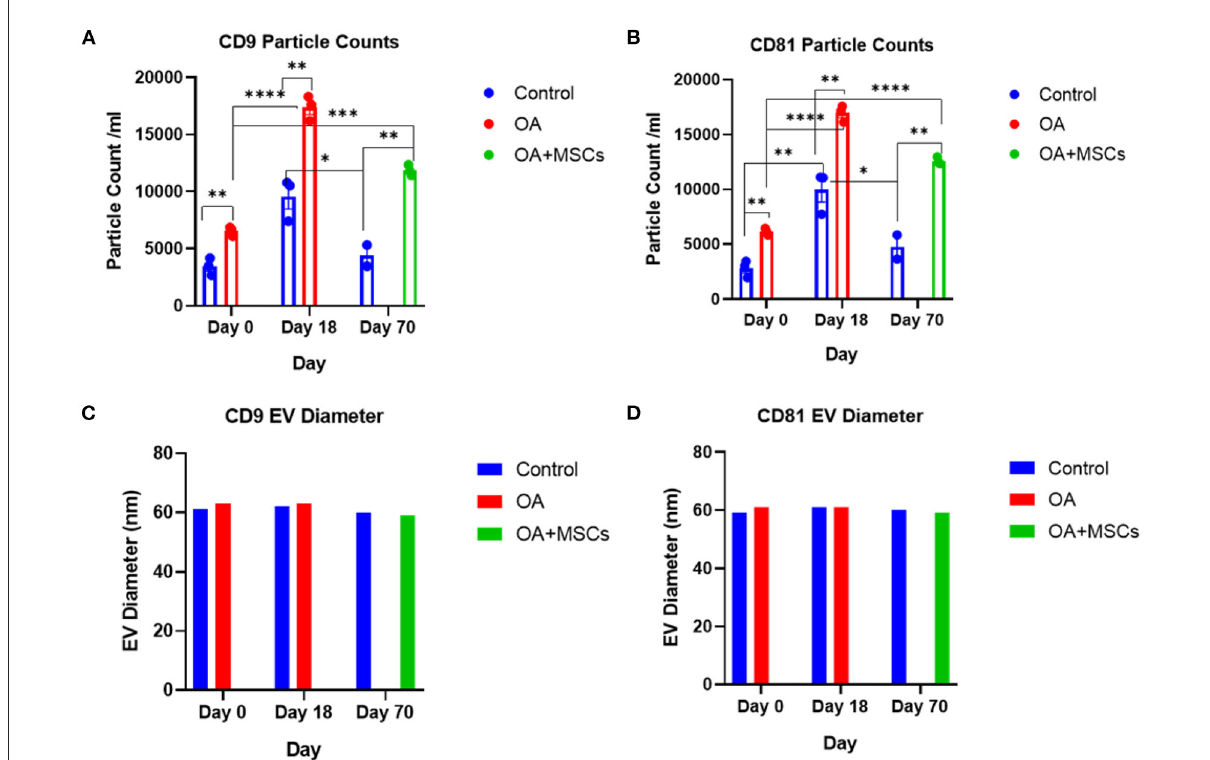
FIGURE2 Sizing and enumeration of synovial fluid-derived EVs. All data was adjusted for dilution of the sample onto the chip. Shown is the average representing mean of three technical replicates that were run for each sample. Particle numbers were quantified by the number of particles in a defined area on the antibody capture spot. All bars are mean and standard error mean. (A) CD9 and (B) CD81-positive particles following probing with fluorescent tetraspanin antibodies. (C) Sizing of CD9 and (D) CD81 labeled EVs, normalized to MIgG control. Limit of detection